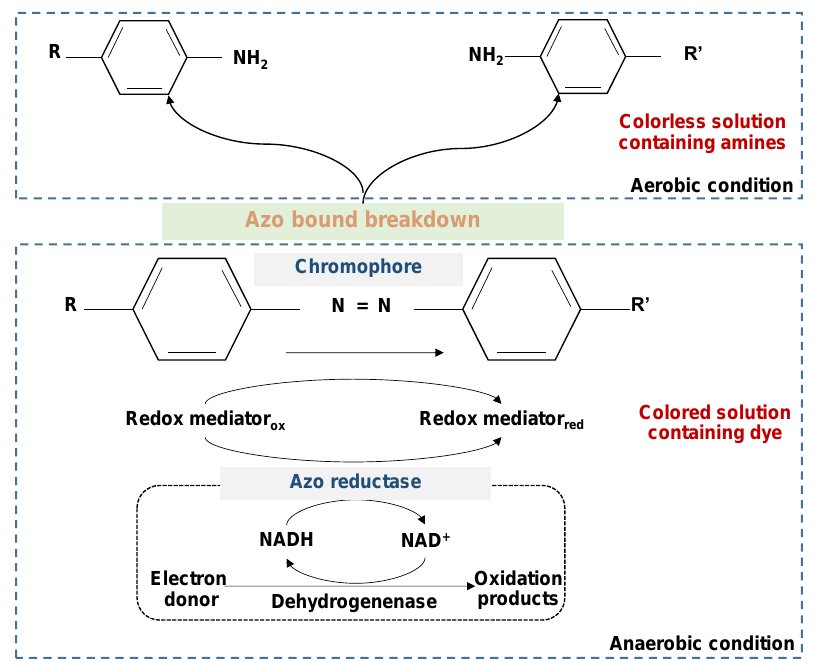
Figure 1. Proposed mechanism for reduction of dye by bacterial cell adaptation from [12].